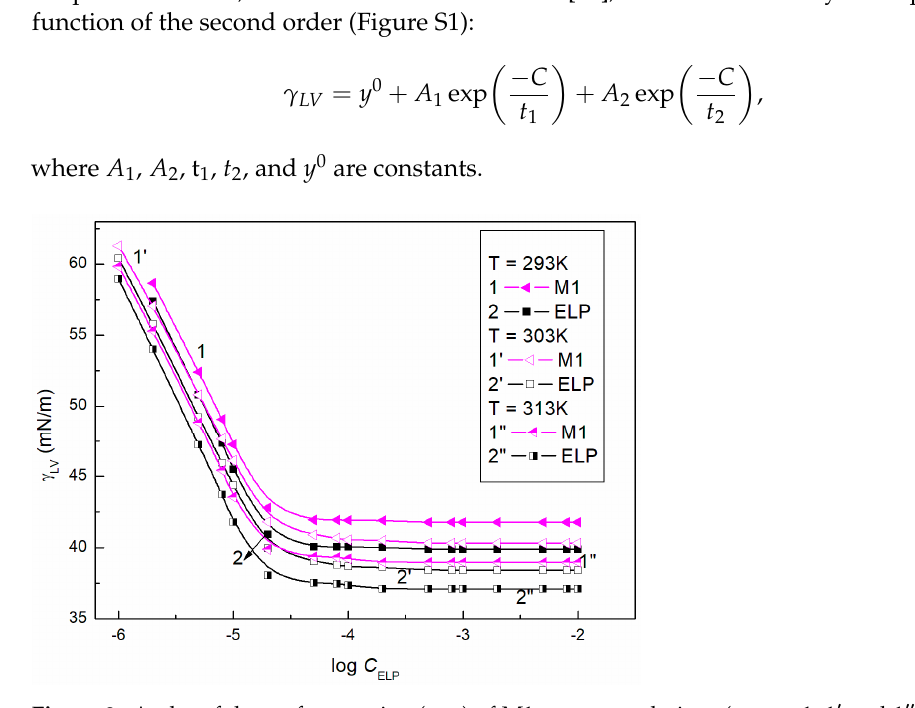
Figure 2. A plot of the surface tension ( γ LV ) of M1 aqueous solutions (curves 1, 1 (cid:48) and 1 (cid:48)(cid:48) ) and ELP aqueous solutions [22] (curves 2, 2 (cid:48) and 2 (cid:48)(cid:48) ) vs. the logarithm of ELP concentration (log C ELP ) at a constant temperature equal to 293 K (curves 1 and 2), 303 K (curves 1 (cid:48) and 2 (cid:48) ), and 313 K (curves 1 (cid:48)(cid:48) and 2 (cid:48)(cid:48)